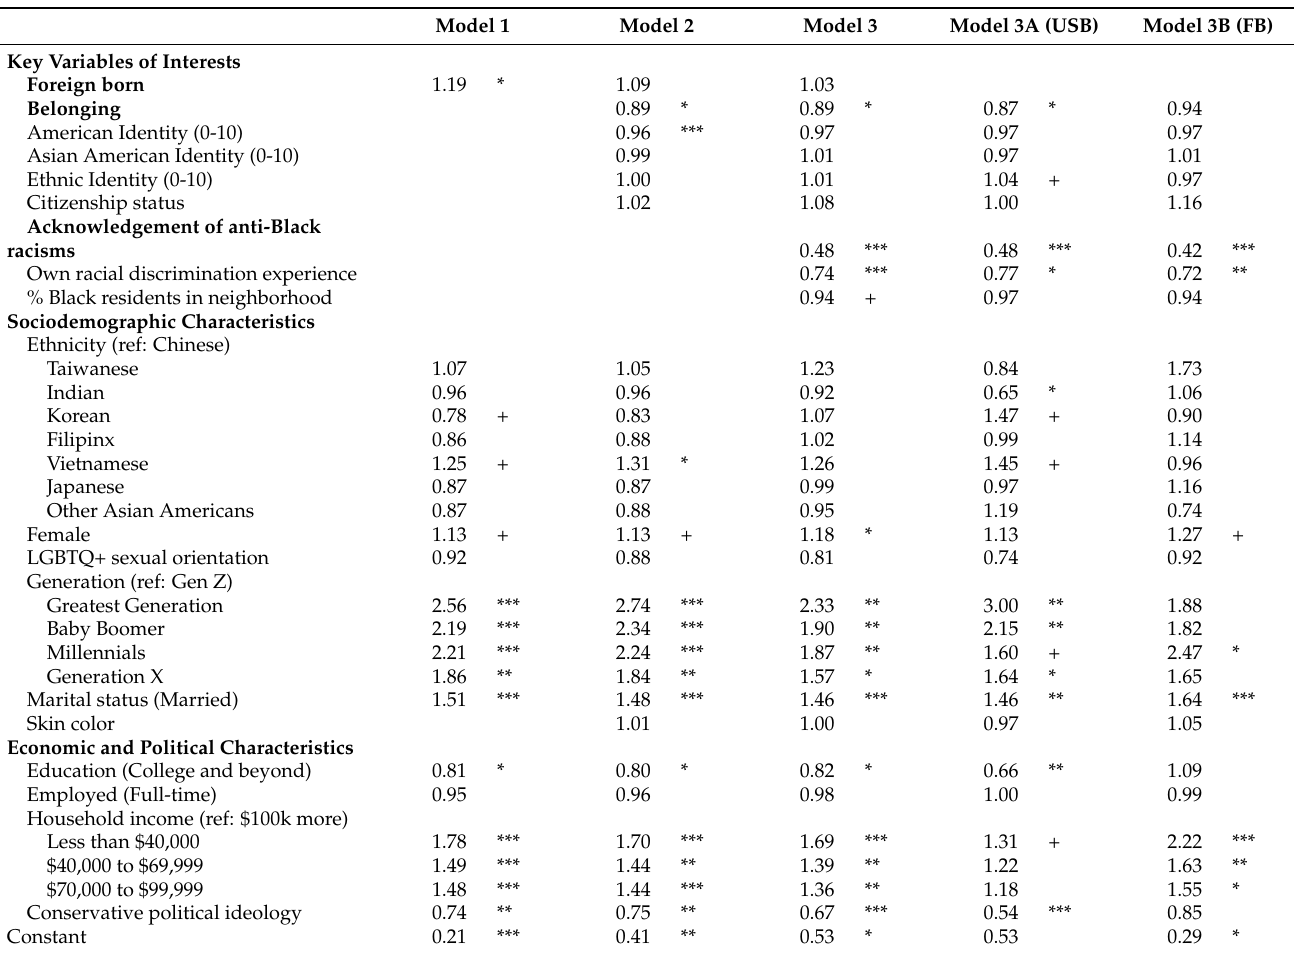
Table 3. Weighted logistic regression predicting indifference in support BLM (odds ratios). Source: 2016 Collaborative Multiracial Post-election Survey (CMPS). Note: Statistics a Significant tests of difference compared to U.S.-born Asian Americans, p < 0.05 (one-tailed test); * p < 0.05, ** p < 0.01, *** p < 0.001, + p <